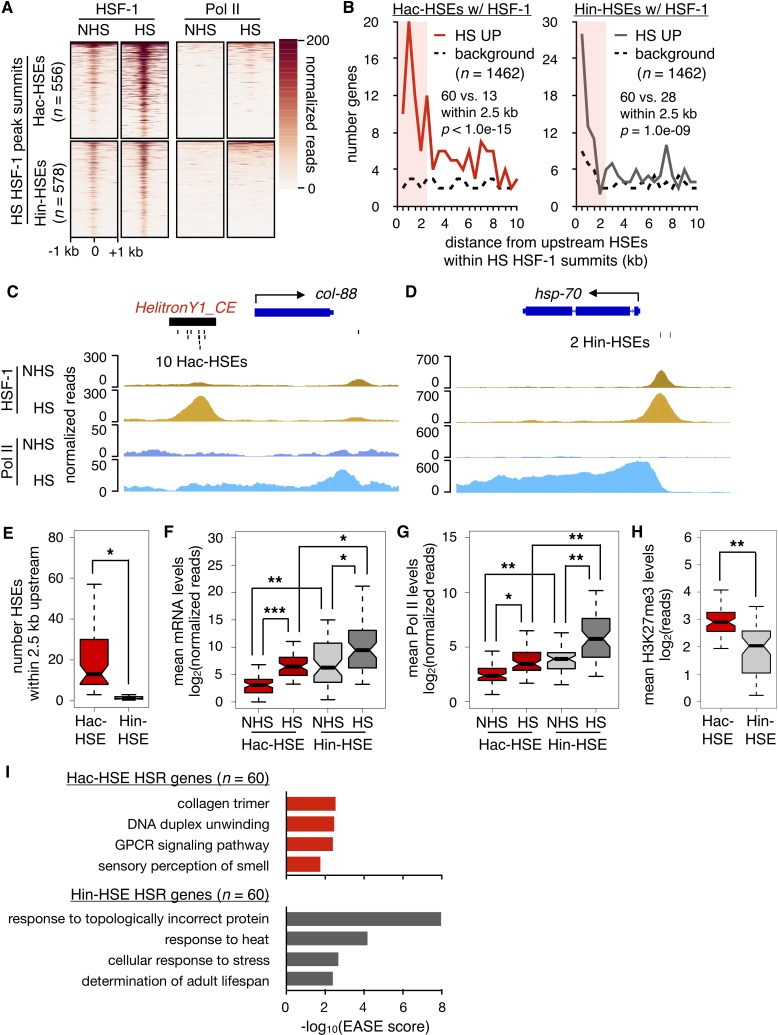
HSR genes with adjacent Hac- or Hin-HSEs display different properties.(A) Heatmap displaying normalized (see Materials and methods for details) HSF-1 and Pol II ChIP-seq reads over 2 kb regions centered on Hac-HSE- and Hin-HSE-containing HS HSF-1 peak summits. ChIP data are from Li et al. (2016). (B) Number of genes within 500 bp bins versus distance from upstream Hac- and Hin-HSEs that reside within HS HSF-1 peak summits. HS UP genes (n = 1462) are those with a fold change after HS >2 and an adjusted p-value<0.01 determined using DESeq2 (Love et al., 2014). For Hac-HSEs, 60 HS UP (red solid line) vs. 13 background (black dashed line) genes reside within 2.5 kb, resulting in a significant enrichment (p<1.0e-15, χ2 test). For Hin-HSEs, 60 HS UP (gray solid line) vs. 28 background (black dashed line) genes reside within 2.5 kb, resulting in a significant enrichment (p=1.0e-09, χ2 test). HS UP genes that have HSEs within HSF-1 peak summits less than 2.5 kb upstream from annotated transcriptional start sites are considered to be part of the heat-shock response (HSR genes). (C) Genome browser screenshot of normalized HSF-1 (goldenrod) and Pol II (blue) ChIP-seq reads (note scale differences) in the vicinity of the Hac-HSE HSR gene col-88. The 10 Hac-HSEs located within the HelitronY1_CE sequence found in the upstream promoter region are shown. (D) Genome browser screenshot of normalized HSF-1 and Pol II ChIP-seq reads (note scale differences) in the vicinity of the Hin-HSE HSR gene hsp-70. The two Hin-HSEs located in the upstream promoter region are shown below the gene structure. (E) Notched boxplot showing distributions of the number of HSEs located within 2.5 kb upstream of Hac- (red, n = 60) or Hin-HSE (gray, n = 60) HSR genes. Notches represent 95% confidence intervals of the median. (F) Notched boxplot showing distributions of DESeq2-normalized steady-state mRNA levels during NHS and HS conditions for Hac- or Hin-HSE HSR genes. As some Hac-HSE HSR genes were undetectable under NHS conditions, a single read was added to all genes to allow for log transformation. (G) Notched boxplot showing distributions of normalized Pol II ChIP-seq reads obtained during NHS and HS conditions over Hac- or Hin-HSE HSR gene bodies. (H) Notched boxplot showing distributions of H3K27me3 ChIP-seq reads using publicly available data obtained from L3 stage worms during NHS conditions (Ho et al., 2014) over Hac- or Hin-HSE HSR gene bodies. H3K27me3 data were obtained from the modMine database (intermine.modencode.org) (Contrino et al., 2012) under accession number modEncode_5051. For panels E-H, a single asterisk represents p<1.0e-04, double asterisks represent p<1.0e-08, and triple asterisks represent p<1.0e-12 (Welch Two Sample t-test). (I) Significantly enriched gene ontology (GO) terms identified using DAVID (Huang et al., 2009a; Huang et al., 2009b) for Hac-HSE (red) and Hin-HSE (gray) HSR genes.